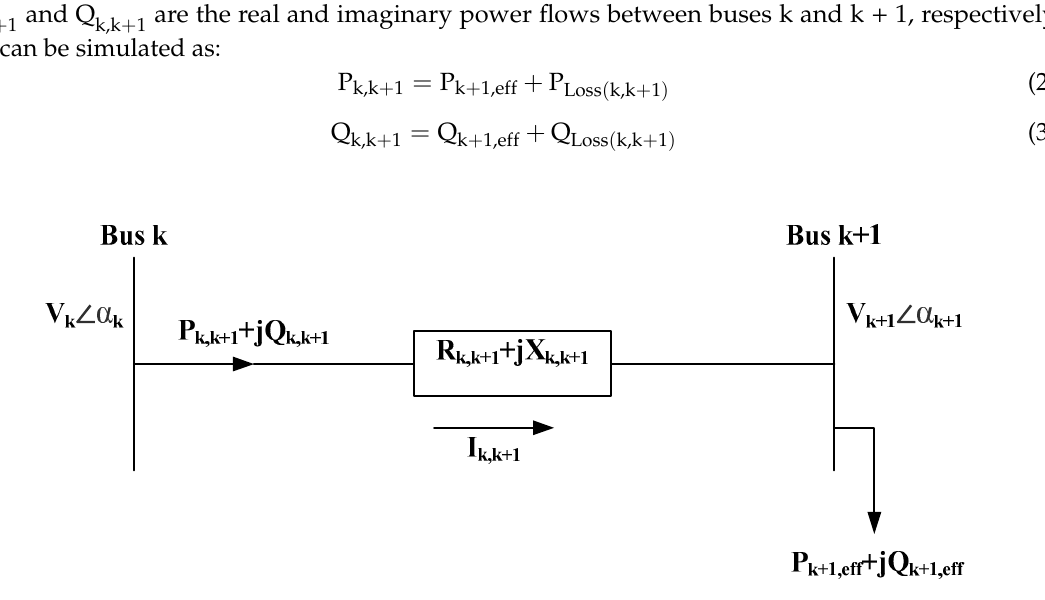
Figure 1. Single line diagram of distribution system.